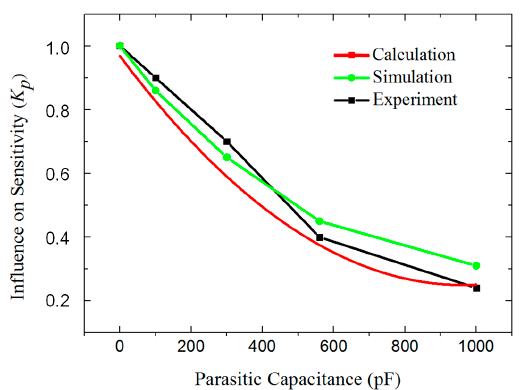
Figure 7. Influence of the parasitic capacitance on the sensitivity, which is defined by the ratio of the output with parasitic capacitance and the output without parasitic capacitance under the same input. Sensors 2017 , 17 , 2158